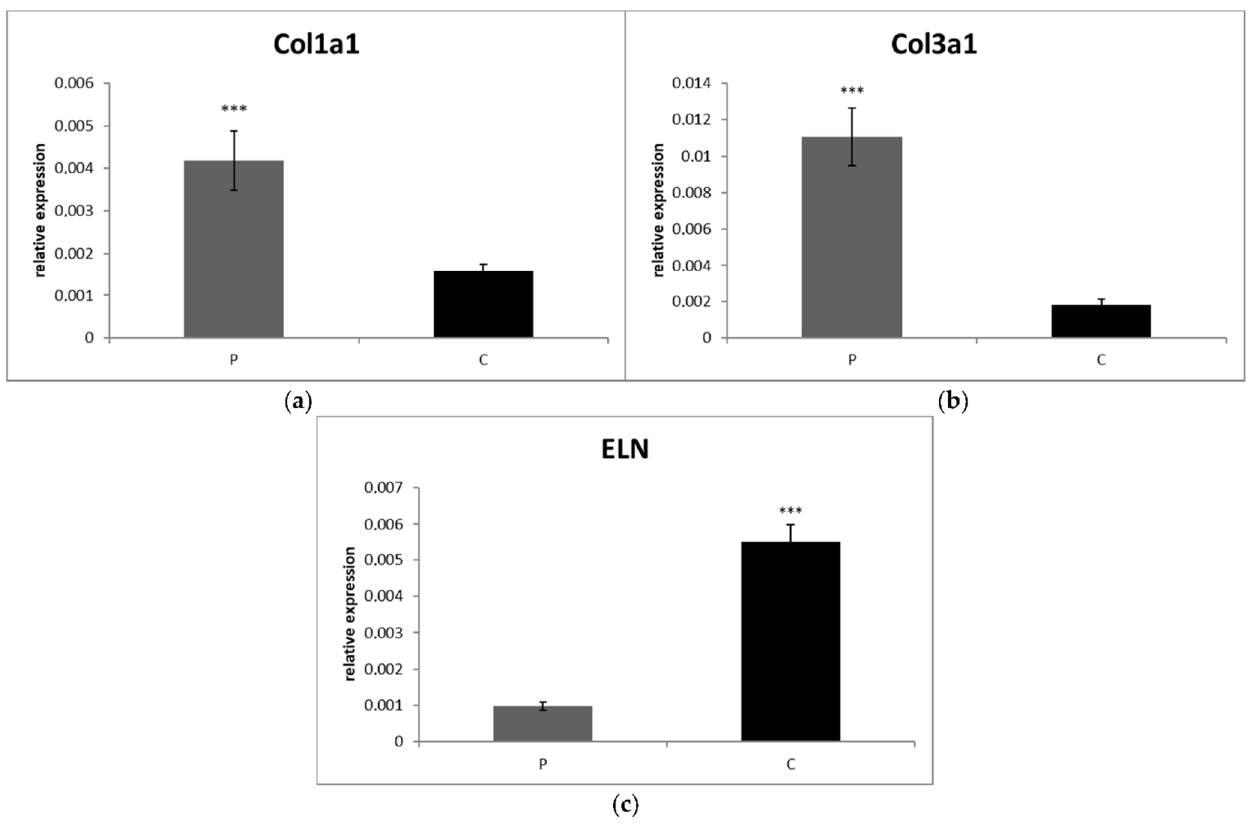
Figure 2. Level of relative gene expression for ( a ) Col1a1, ( b ) Col3a1 and ( c ) ELN (SF). Results at each Table 2. Cq . Columns marked with stars are significantly different between groups: *** p < 0.001. P, patients CrCL group; C, control group.